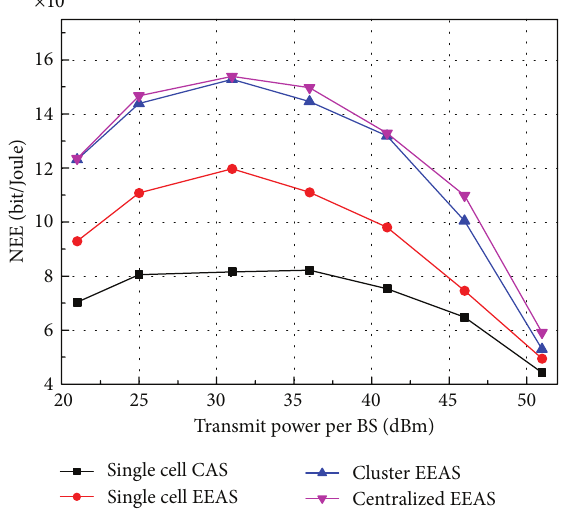
Figure 3: NEE versus transmit power per BS with 𝑁 max = 4 , 10 user per cell and cell radius of